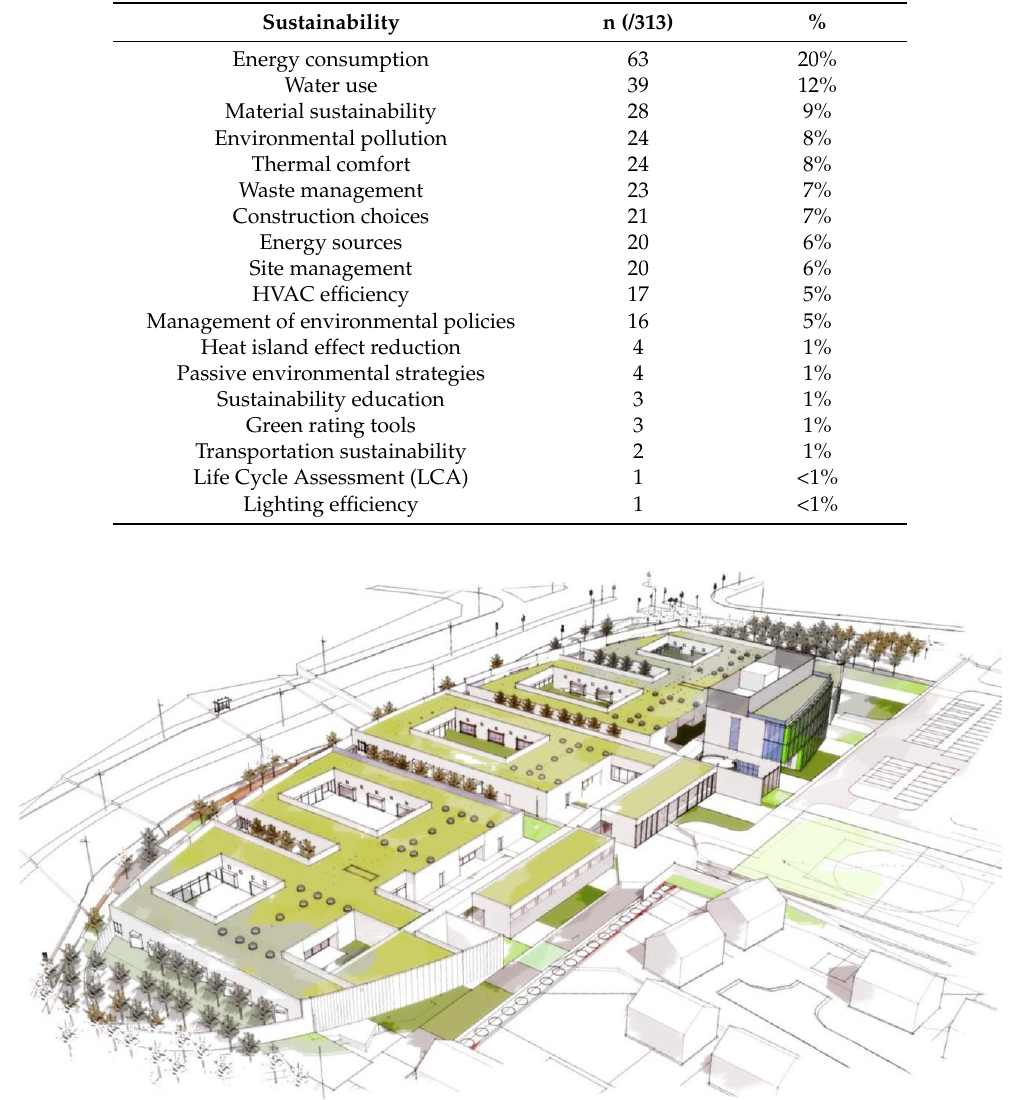
Table 11. Number and percentage of indicators grouped according to Sustainability topics.